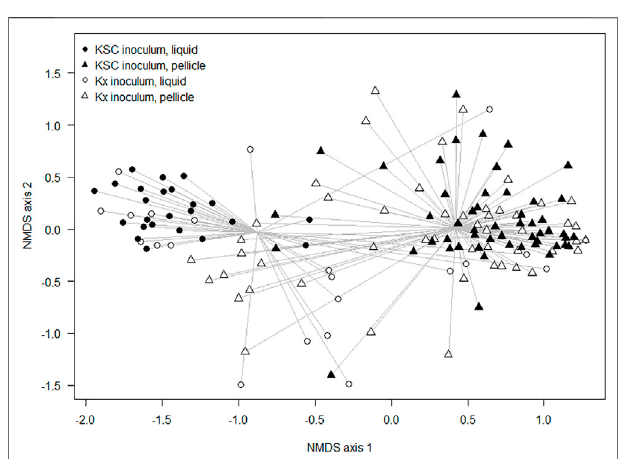
FIGURE 5 | Non-metric multidimensional scaling ordination plot of composition differences of samples (inoculated with either the liquid or pellicle K. xylinus /Kombucha) using the Bray – Curtis dissimilarity index.